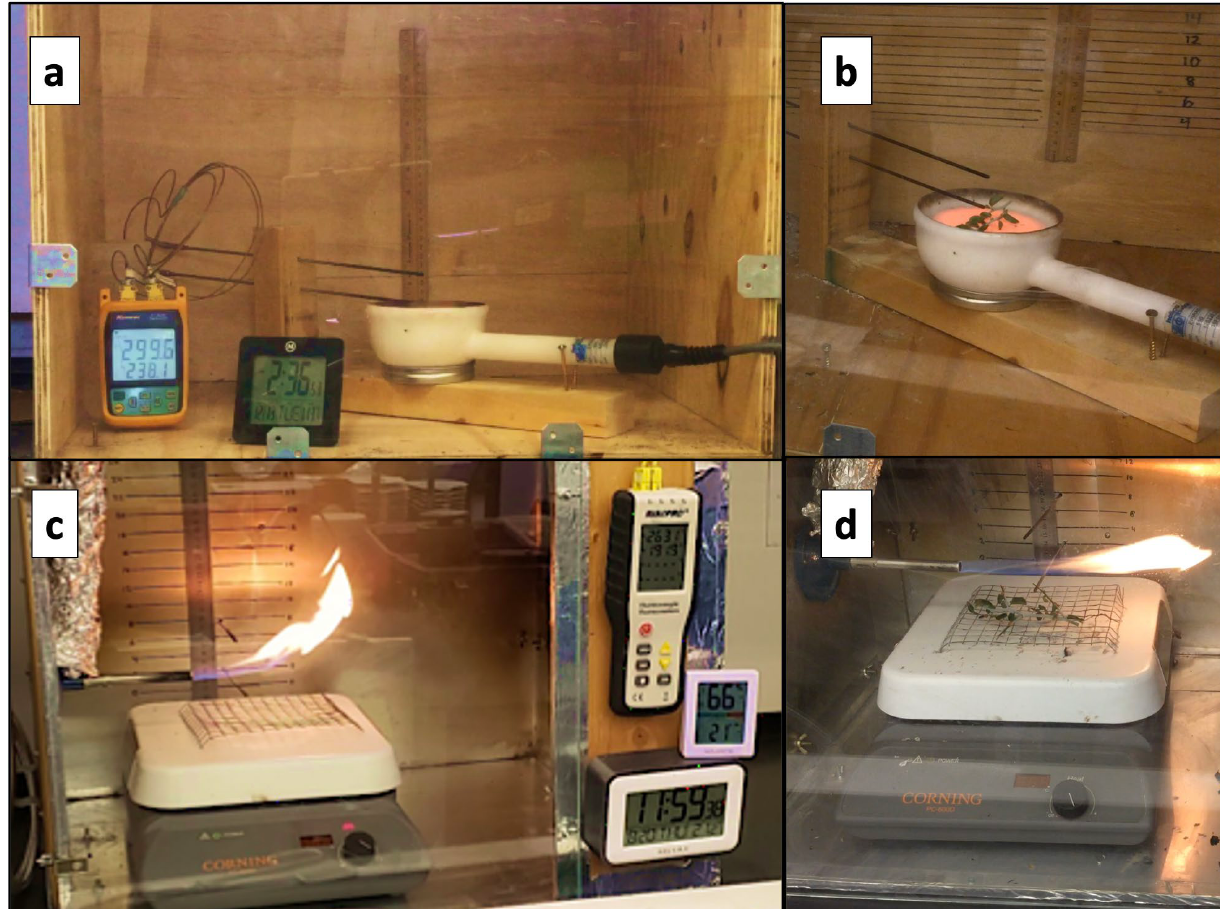
Figure 1. Images of the ( a , b ) epiradiator and ( c , d ) novel hot-plate-based flammability chamber designs used in this study.